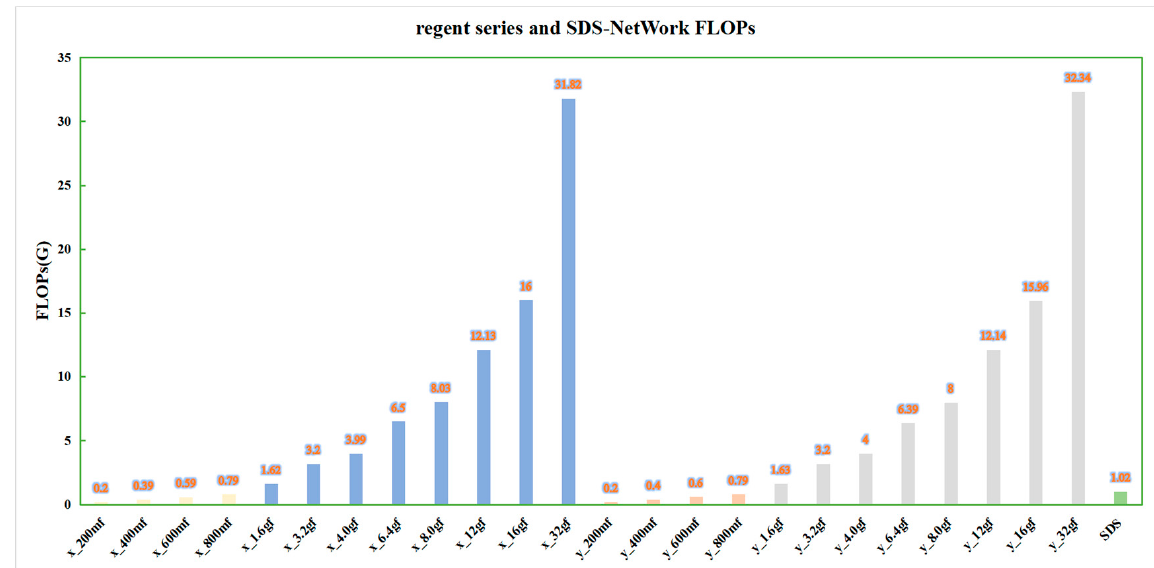
Figure 9. Comparison of FLOPs between SDS-Network and regnet algorithms.